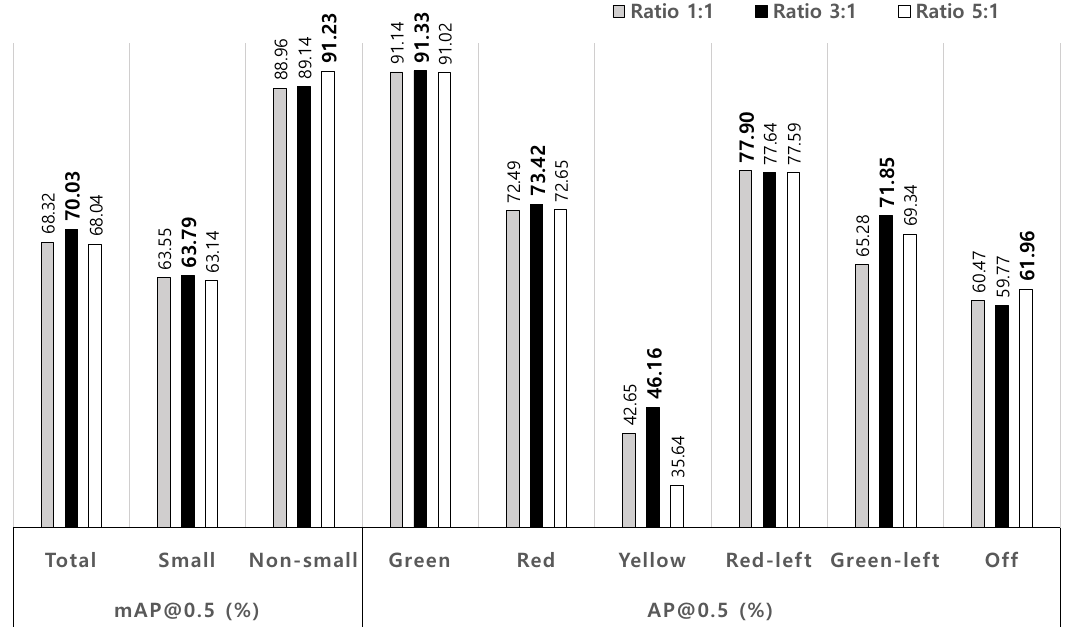
Figure 3. Average TL recognition performances according to ratio of training to test